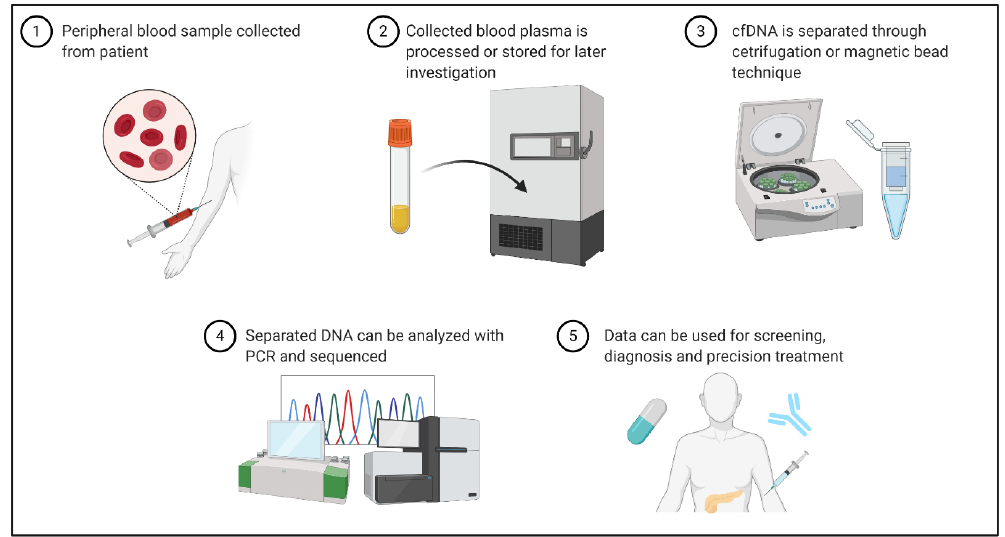
Figure 2. Sample collection, storage, DNA isolation, amplification and sequencing, and clinical application are important steps of ctDNA liquid biopsy. Created with BioRender (BioRender.com, accessed 10 September 2020). PCR, polymerase chain